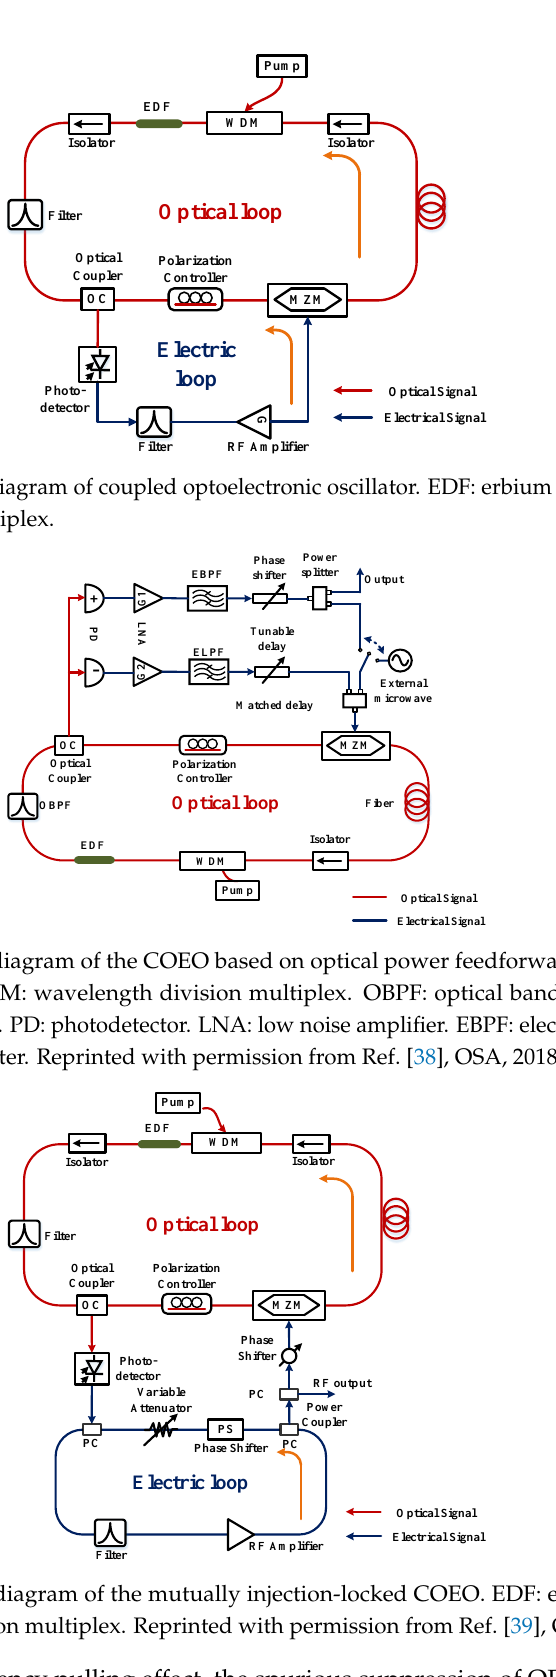
WDM: wavelength division multiplex. Reprinted with permission from Ref. [39], OSA, 2018 .